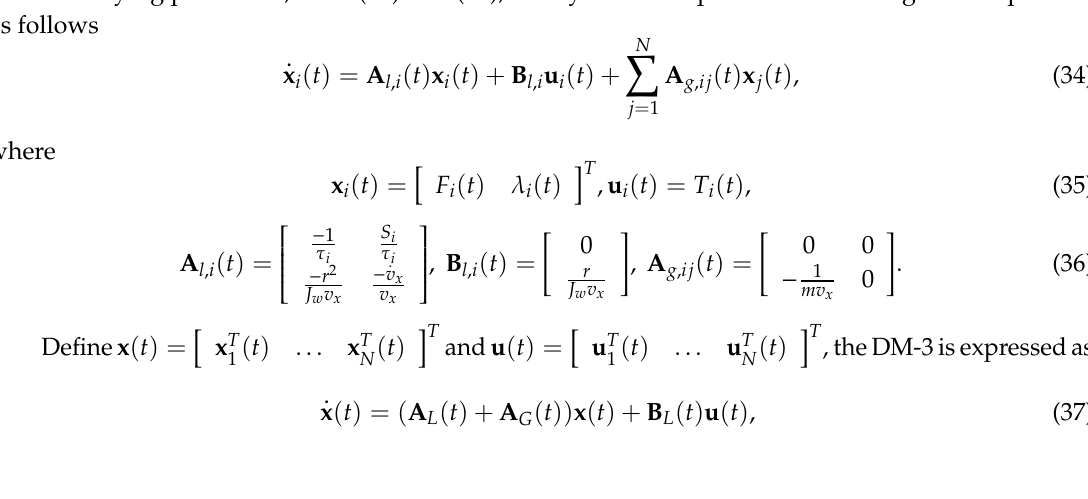
Figure 12. Sector bounded nonlinearities to capture the uncertainty of tire-force characteristics.